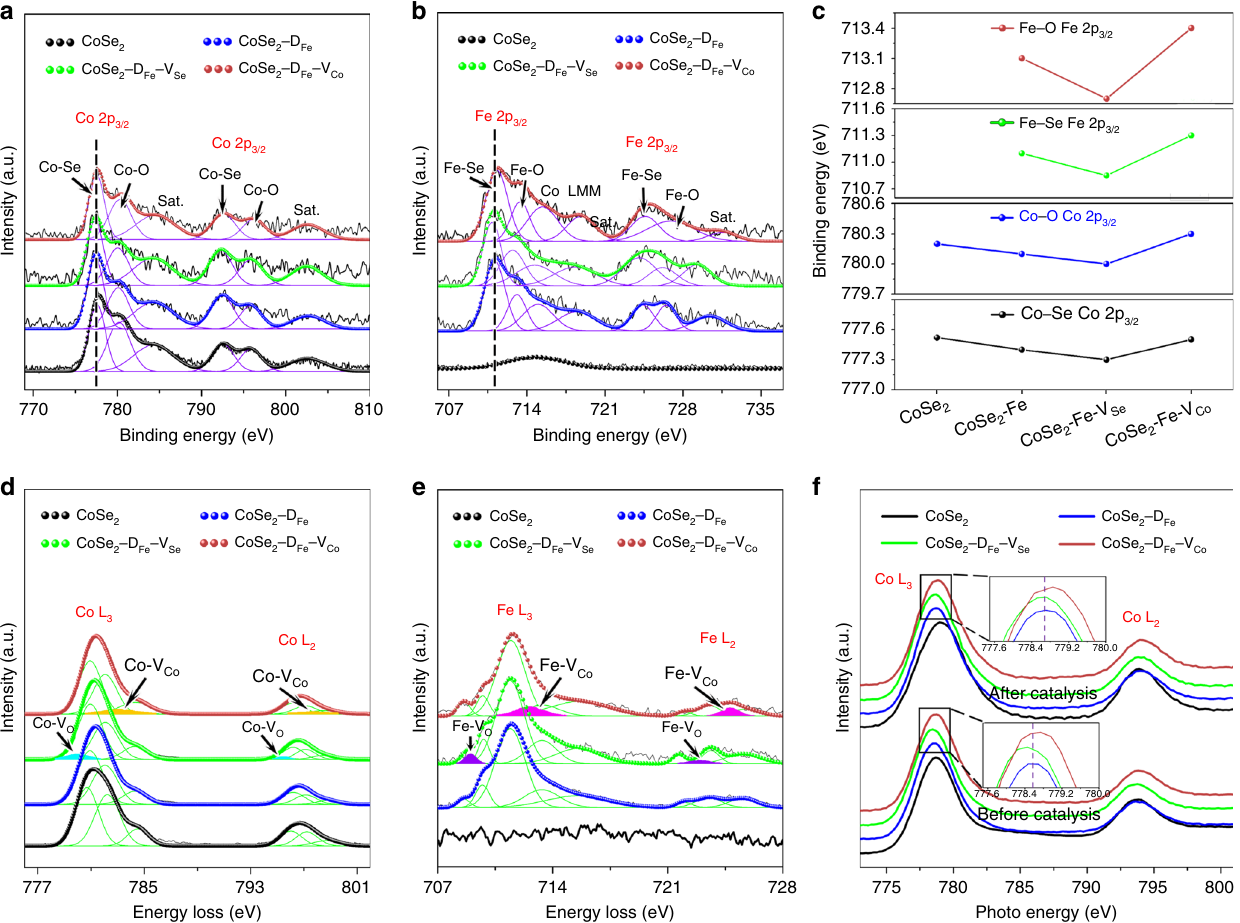
Fig. 3 Defect structure identi fi cation before and after catalysis. a , b Co 2p and Fe 2p X-ray photoelectron spectroscopy spectra of primary catalysts. c Binding energy shifts of Co – Se, Co – O, Fe – Se, and Fe – O peaks due to doping and vacancies. d , e Co and Fe L-edge electron energy loss spectra after chronoamperometry test at 370 mV for 1.5 h showing the existence of extra peaks in CoSe 2 – D Fe – V Se and CoSe 2 – D Fe – V Co . f Co L-edge X-ray absorption near-edge structure spectra before and after catalysis showing the energy shifts caused by doping and